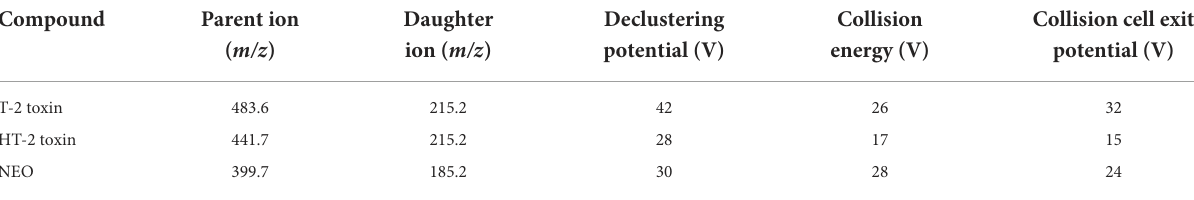
TABLE 1 Mass spectrometric settings for quantification of T-2 toxin, HT-2 toxin, and NEO.